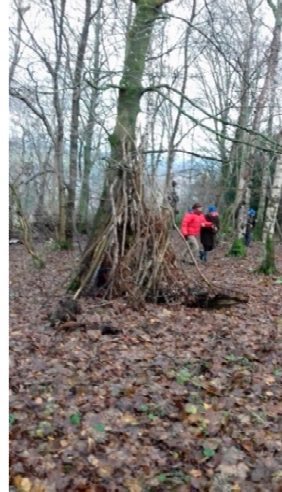
Figure 1. Extending Practice Sessions at the Haining and Bowhill Woods. Image, author’s own.